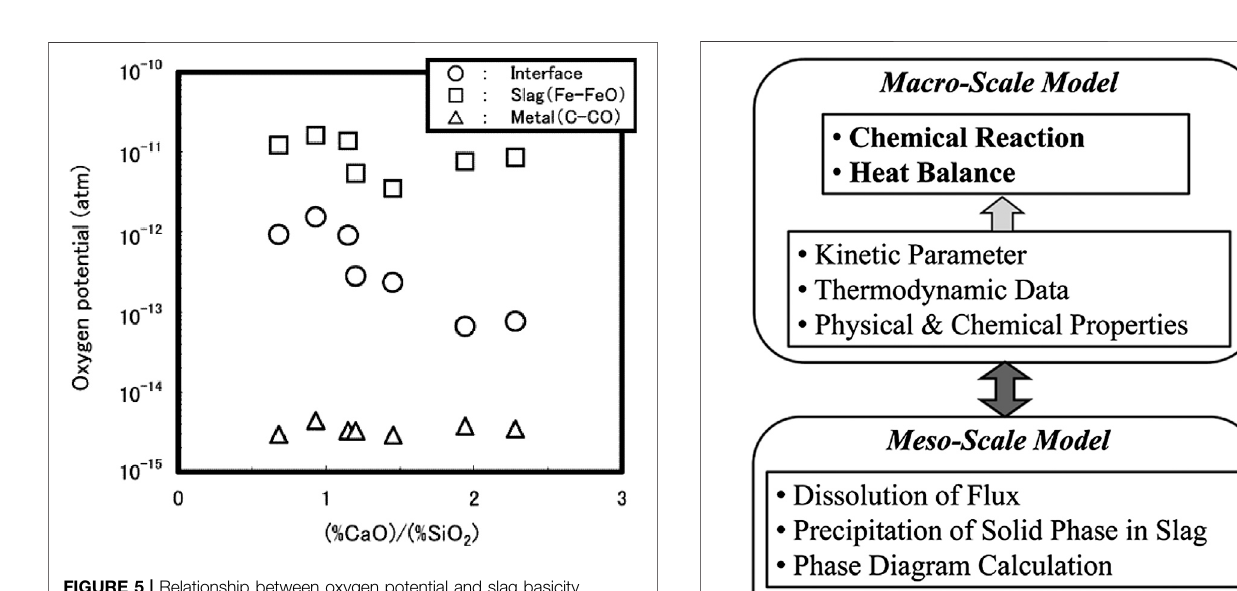
FIGURE 5 | Relationship between oxygen potential and slag basicity (Miyamoto et al., 2009). [Figure 10 of (Miyamoto et al., 2009), Copyright The Iron and Steel Institute of Japan].